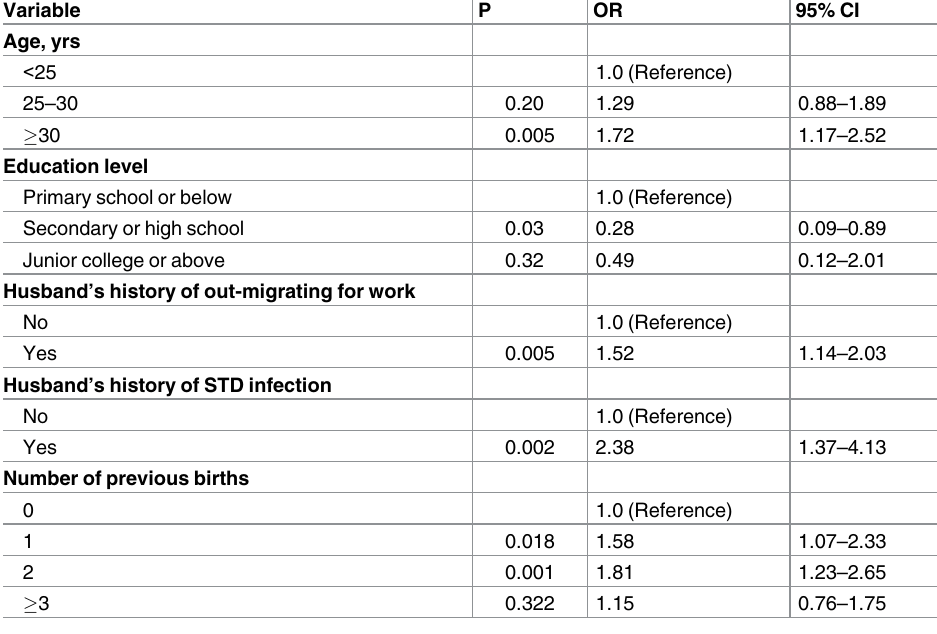
Table 3. Multivariate logistic regression analysis of factors associated with HIV positivity in pregnant women of Zhaojue and